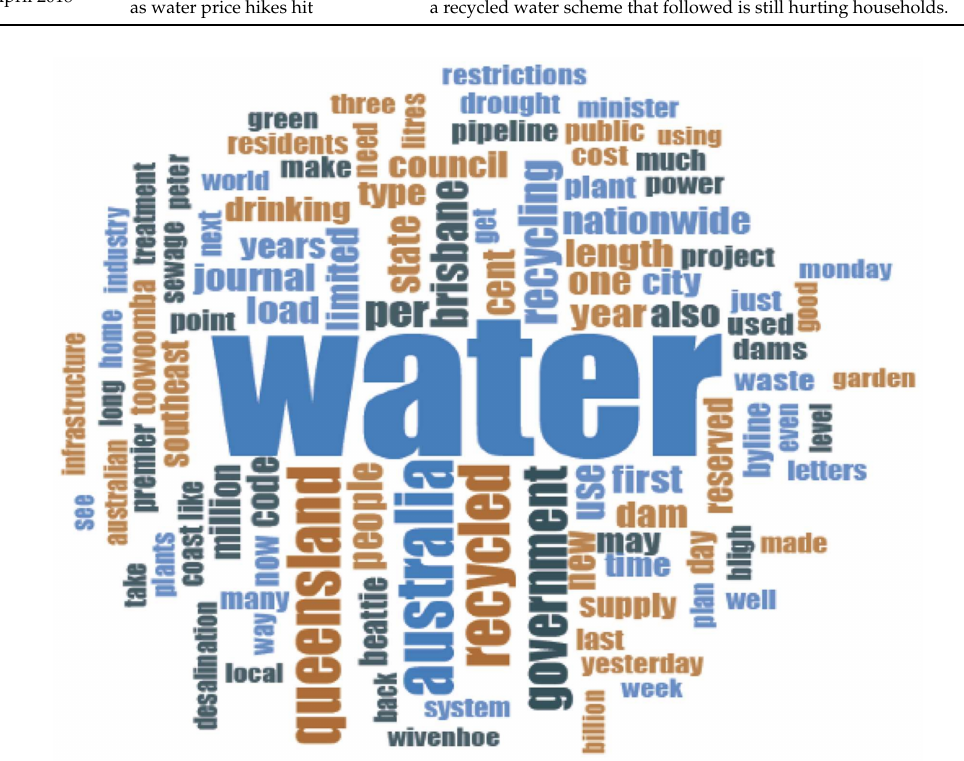
Figure 4. The Courier-Mail : terms associated with potable water